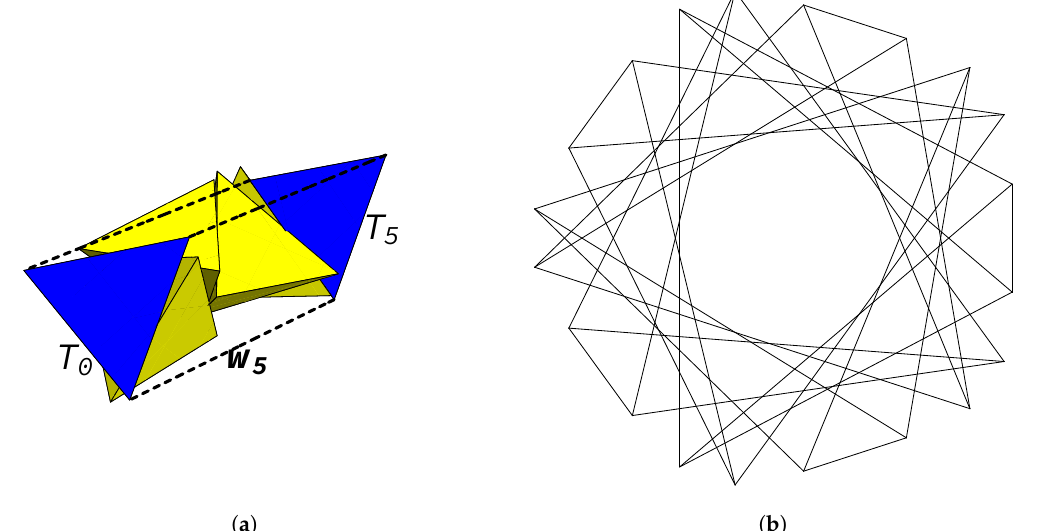
Figure 5. The periodicity of the 5-BC helix: ( a ) the vertices of T 5 are the vertices of T 0 translated by w 5 ; ( b ) a projection of the 5-BC helix along its central axis.